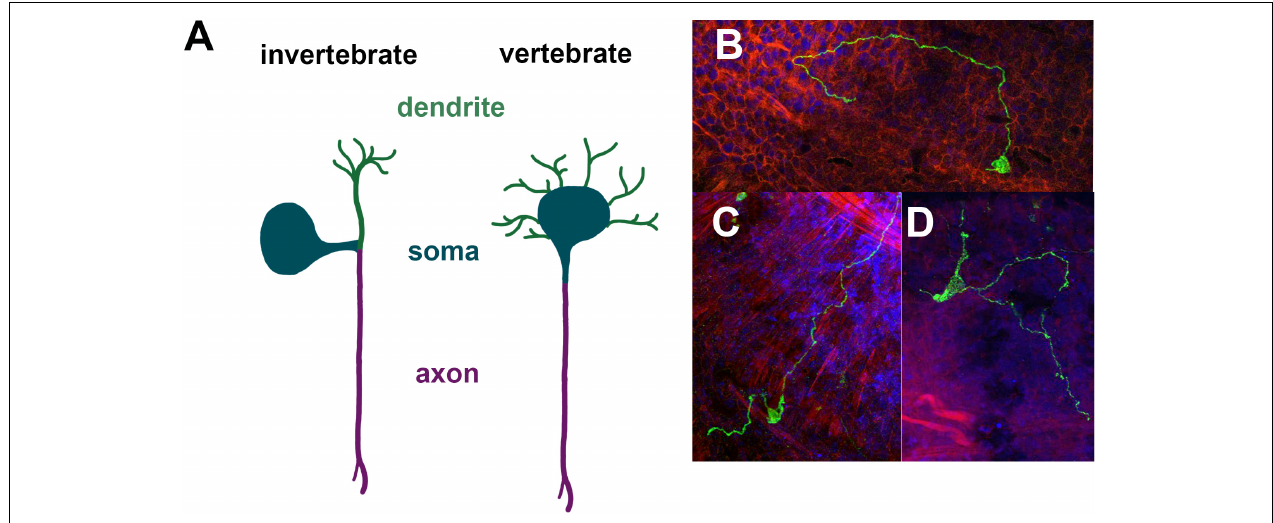
FIGURE 2 | Morphological properties of cnidarian neurons. Prototype invertebrate neuron with a unique primary neurite compared to the prototype vertebrate neuron with a single axon and multiple dendritic arbors (A) . Unipolar, bipolar and tripolar neurons in Nematostella expressing Elav-mOrange in mosaic animals (B–D) .